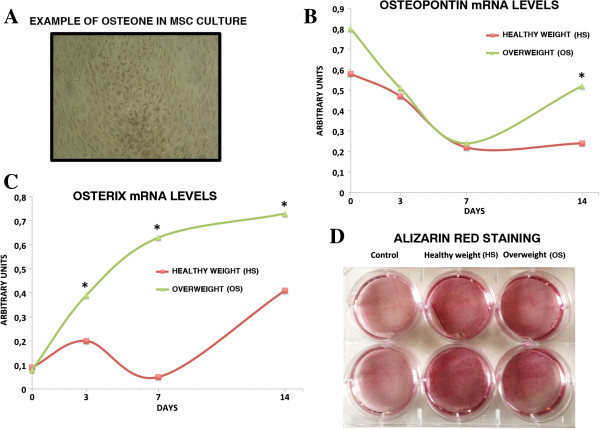
Analysis of osteocyte differentiation. A) The picture shows a representative image of an osteon formation following osteocyte differentiation of MSCs. Image taken on an upright inverted microscope with a 20× objective. The graph represents the expression follow up of osteopontin (B) and osterix (C) during osteocyte differentiation of MSCs treated with OS or HS. mRNA levels were normalized with respect to GAPDH, which was chosen as an internal control. Each experiment was repeated at least three times. The histogram shows the mRNA expression levels. They are expressed as arbitrary units (*P <0.05). D) The picture shows Alizarin red staining of MSCs treated with OS or HS and then induced to differentiate into osteocytes. Control: cells not induced to differentiate. The Alizarin red staining intensity for each cell culture dish was acquired with a CCD camera and analyzed with Quantity One 1-D analysis software (Bio-Rad). We calculated the sum of the fluorescent pixel values of stained cells and then determined the average fluorescent pixel intensity. HS, healthy weight sera; MSCs, mesenchymal stem cells; OS, overweight sera.